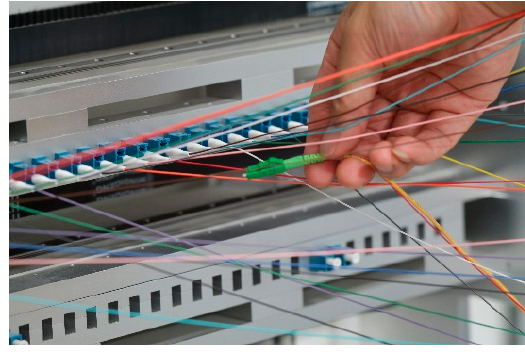
Figure 2. Manual switching process.